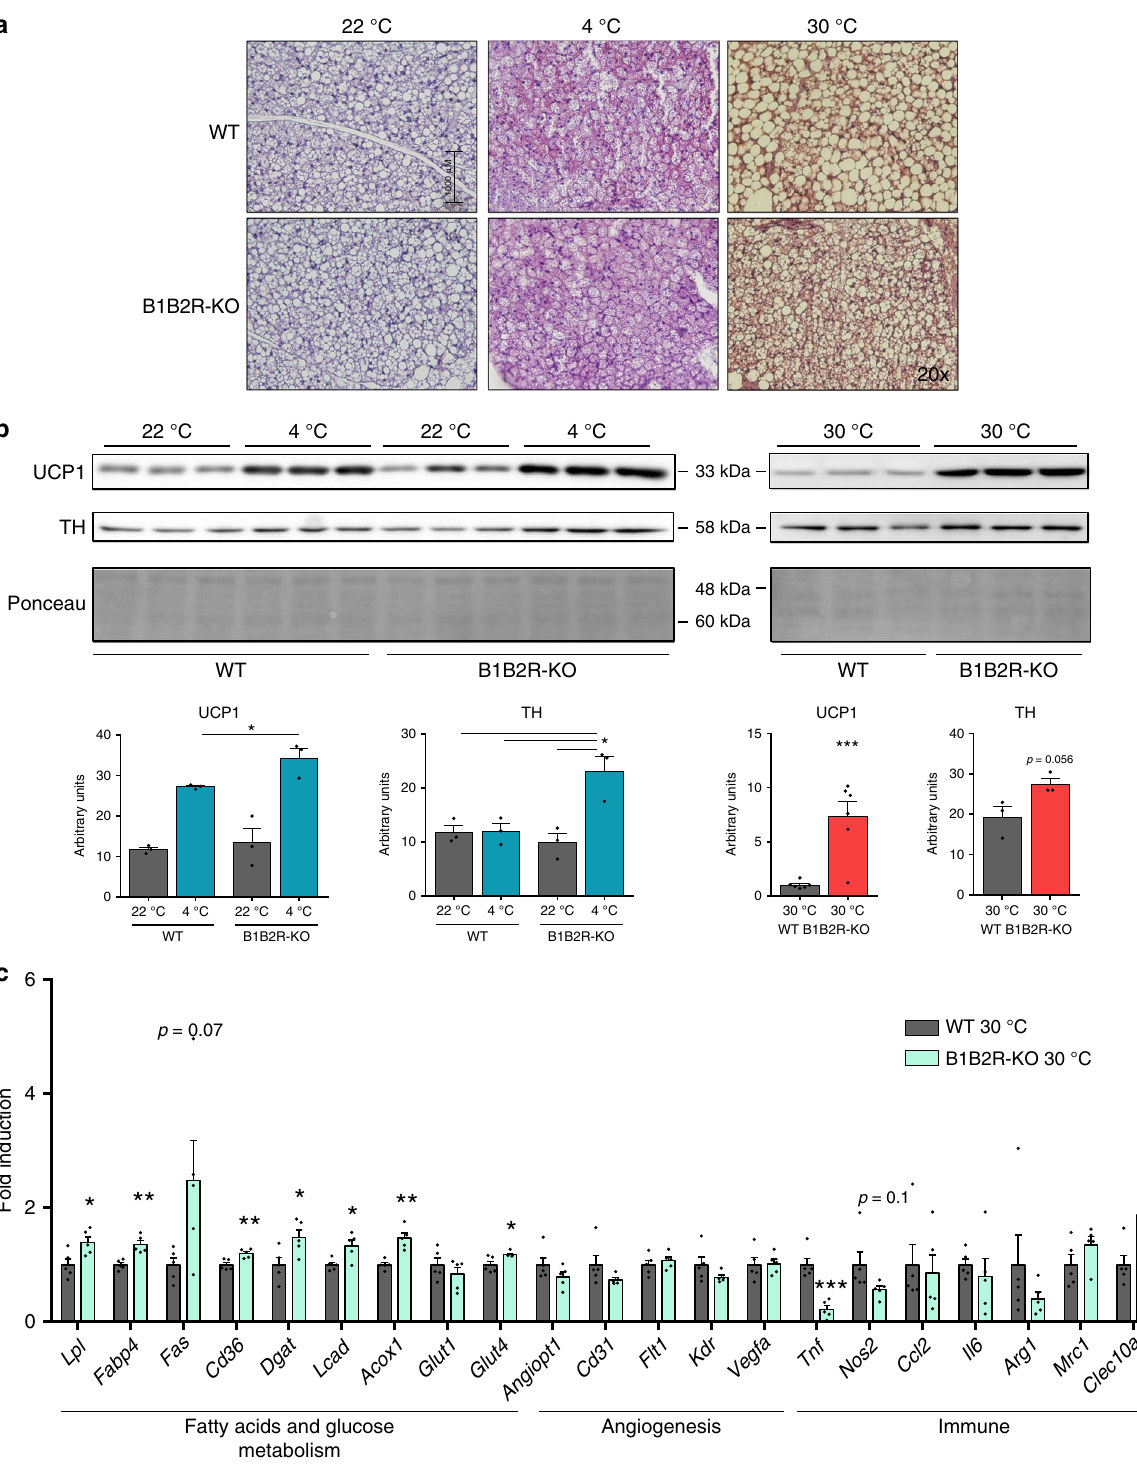
Fig. 6 Effects of temperature challenges on BAT from B1B2R-KO mice. a H&E-stained histological sections (at least 3 different pictures) of iBAT from 3 months old WT and B1B2R-KO exposed to 4 °C or 30 °C for 1 week. b Expression and quanti fi cation of UCP1 and TH protein ( n = 3 animals except for UCP1 30 °C where n = 6). c mRNA expression of genes involved in fatty acid and glucose metabolism, angiogenesis, and the immune system ( n = 5 animals). Data are presented as means ± s.e.m. (bars). * P < 0.05, ** P < 0.01 and, *** P < 0.001 versus corresponding controls; two-tailed unpaired Student ’ s t -test. Source data are provided as a Source data fi